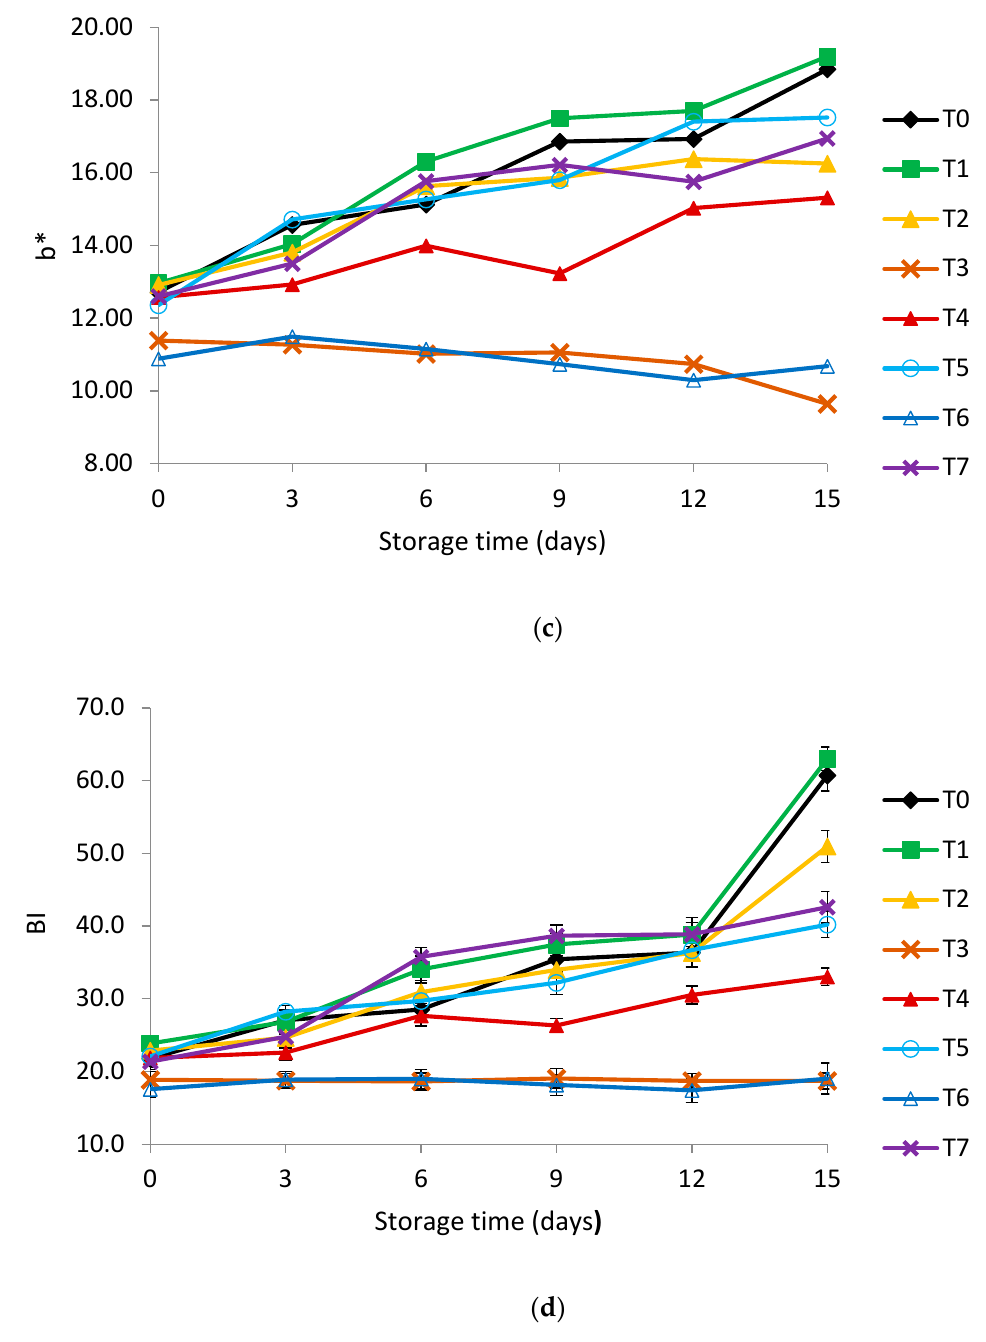
Figure 2. Color values and browning index of control and treated fresh-cut pears stored for 15 days at 8 ± 1 °C. T0—Control; T1—0.2% PE + 1% CaCl 2 ; T2—0.2% PE + 1% CaCl 2 + 0.2% PS; T3—0.2% PE + 1% CaCl 2 + 0.2% PS + 1% N -AC; T4—0.2% PE + 1% CaCl 2 + 0.2% PS + 1% CA + 1% AA; T5—0.2% PE + 1% CaCl 2 + 0.2% SB; T6—0.2% PE + 1% CaCl 2 + 0.2% SB + 1% N -AC; T7- 0.2% PE + 1% CaCl 2 + 0.2% SB + 1% CA + 1% AA. ( a ) Lightness (L*); ( b ) redness (a*); ( c ) yellowness (b*); ( d ) browning index (BI), BI = 100 (x − 0.31)/0.172, x = (a* + 1.75L*)/(5.646L* + a* − 3.012b*). Values are the mean of 27 measurements (3 experiments × 3 replicates × 3 readings/replicate). Error bars represent ± SD.